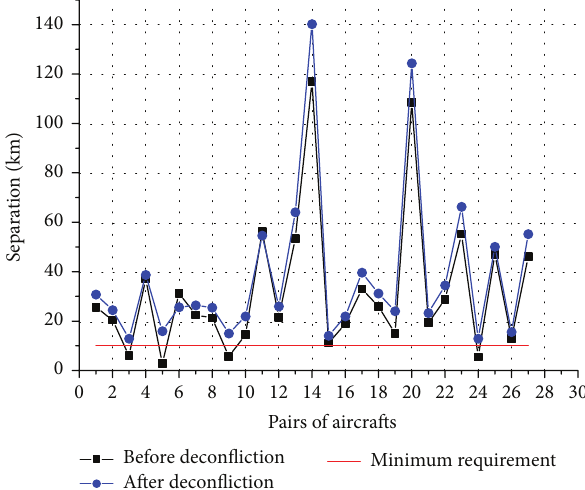
Figure 16: Separation between two adjacent aircrafts arriving at